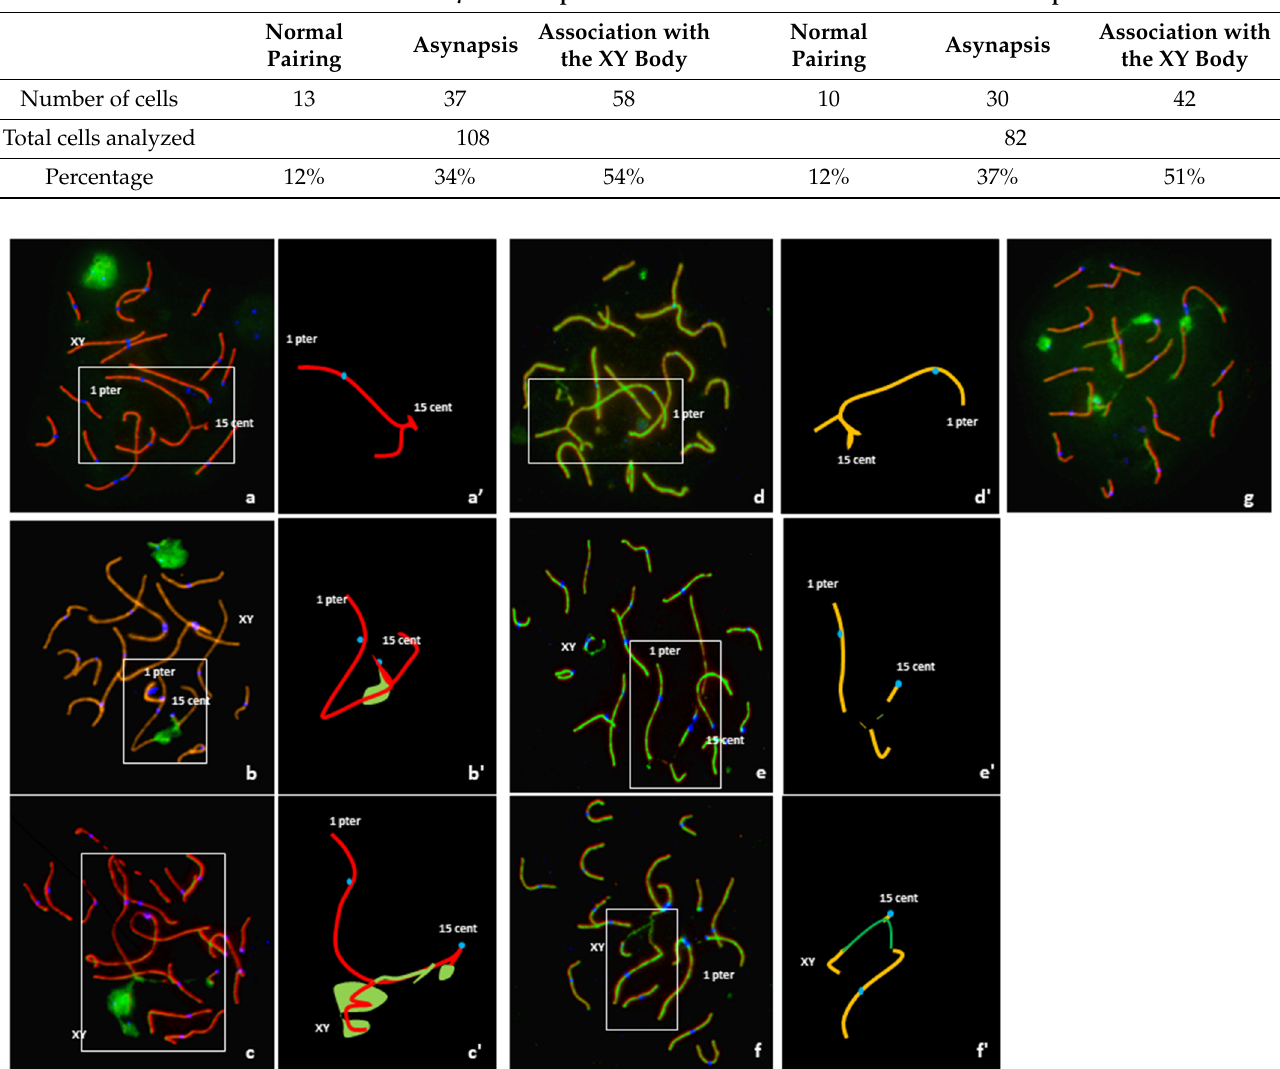
Figure 3. Analysis of meiotic pairing in pachytene spermatocytes using FISH and immunostaining of the synaptonenal complex proteins SCP1 (red) + SCP3 (red), γ H2AX (green) and the centromeres(blue) and graphical representation of